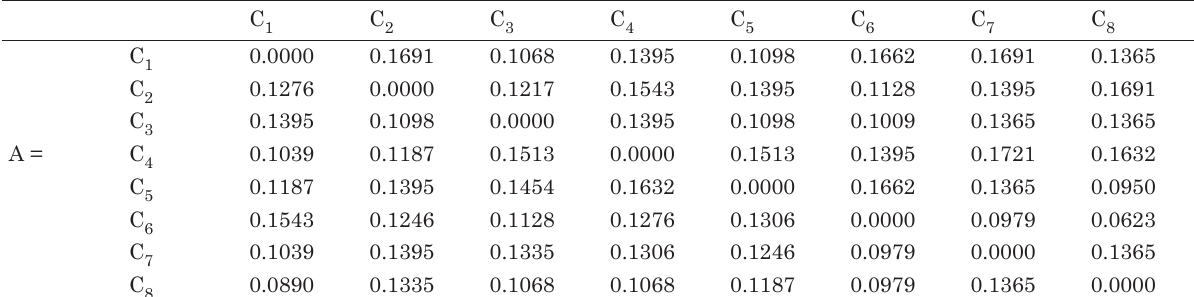
Table 7. Norminalization matrix